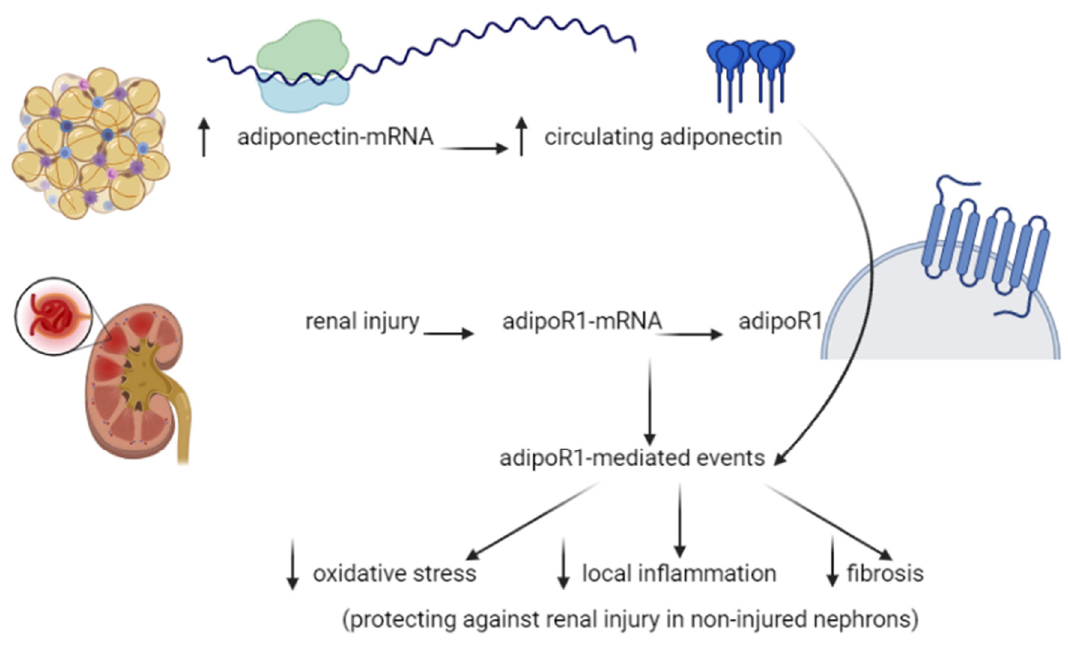
Figure 3. The proposed role of adiponectin in kidney pathophysiology